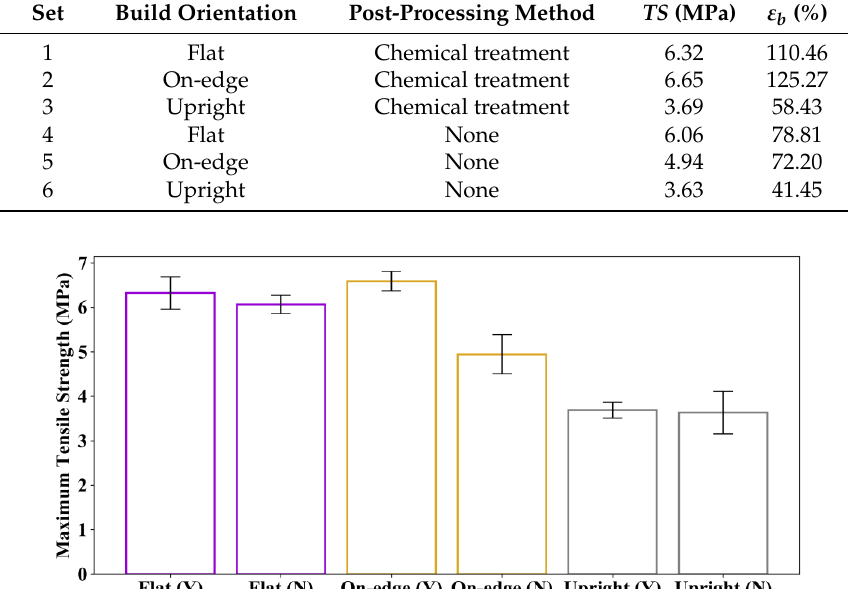
Figure 13. Comparison of the average strain at break. ”Y” indicates specimens with post-processing, and ”N” means specimens without post-processing. Figure 12 shows the comparison of the average maximum tensile strength of the specimens with and without post-processing. As can be seen, post-processing has almost no effect on the tensile strength of specimens printed in flat and upright orientations. The specimens printed in flat orientation have the least number of layers, and the load is parallel to the layers, so the tensile strength mainly depends on the strength of each layer. The specimens printed in upright orientation have the largest number of layers, and the load is perpendicular to the layers. Hence, the tensile strength mainly depends on the bond strength between layers. As post-processing does not affect the strength of each layer and the bond strength between layers, its effect on the tensile strength of specimens printed in flat and upright orientations is very limited. As for the specimens printed in on-edge orientation, the tensile strength is increased by 34.6% compared to those without post-processing. This is because the specimens printed in on-edge orientation have more layers than those printed in flat orientation. Although the applied load is parallel to the layers during testing, delamination may occur due to the small angle between the load and the layers, which could cause premature failure of the specimens. In this case, the tension of the coating formed by the post-processing can suppress delamination, thereby increasing the tensile strength of the specimen. The comparison of the average strain at break of the specimens with and without post- processing is illustrated in Figure 13. It can be seen that the strains at break are considerably increased for specimens with post-processing. The strains at break are increased by 40.2%, 73.5% and 41.0%, respectively, for post-processed specimens printed in flat, on-edge and upright orientations. Figure 14 shows the comparison of the moduli of specimens with and without post-processing. Since post-processing increases the deformability but has little influence on the tensile strength of